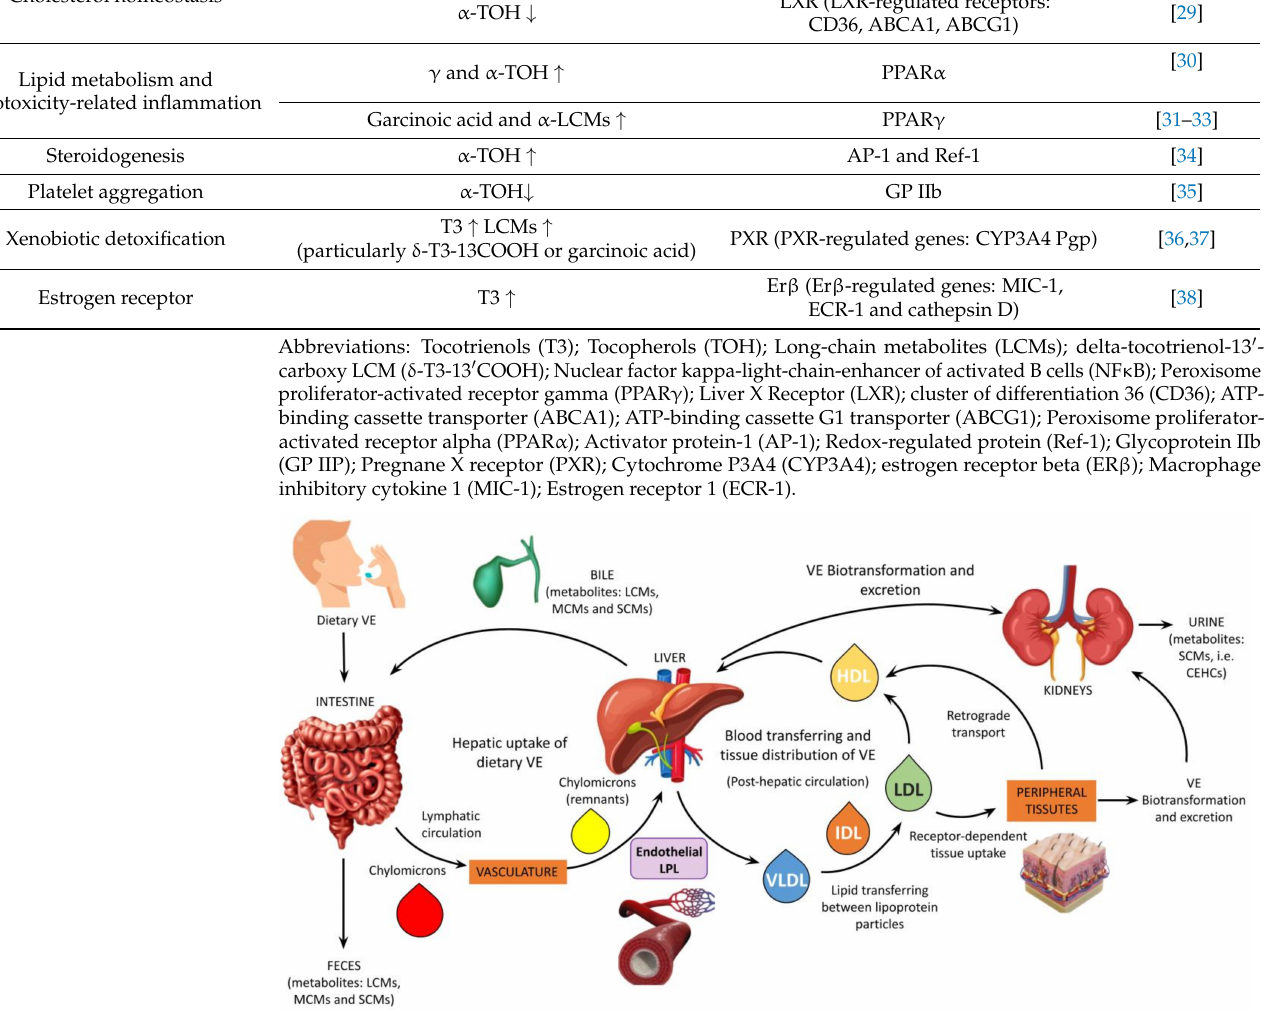
Figure 2. Schematic representation of vitamin E metabolism. The main steps of the intestinal, hepatic, and post-hepatic metabolism of vitamin E are shown. Those in the liver include cellular uptake, subcellular trafficking, biotransformation, incorporation into VLDL particles and excretion for tissue distribution. LCMs: long-chain-metabolites; MCMs: multi-cycling metabolites; SCMs: short-chain- metabolites; CEHCs: carboxyethyl hydroxychromans (natural vitamin E metabolites); VE: vitamin E; LPL: lipoprotein